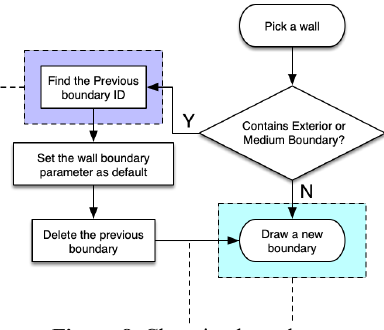
Figure 8. Changing boundary type